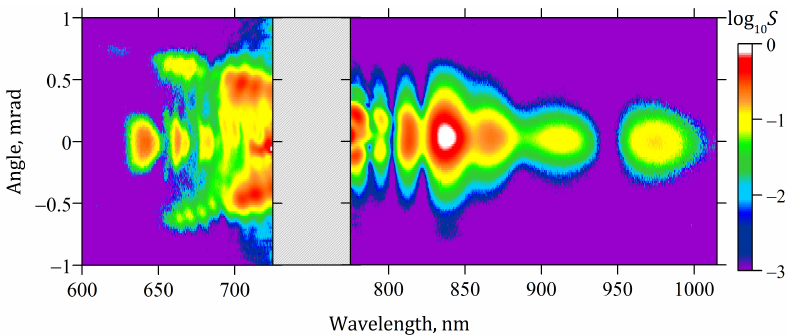
Figure 6. The angle-wavelength spectrum obtained in the experiment in two separate shots for 500–725 nm and 775–1015 nm ranges at the distance 65